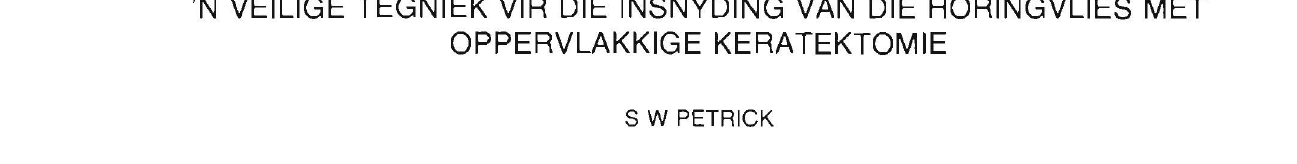
Fig. 1. Die nr. 15 lem vasgeklem in 'n geboe Halstead-muskietaar· klem.